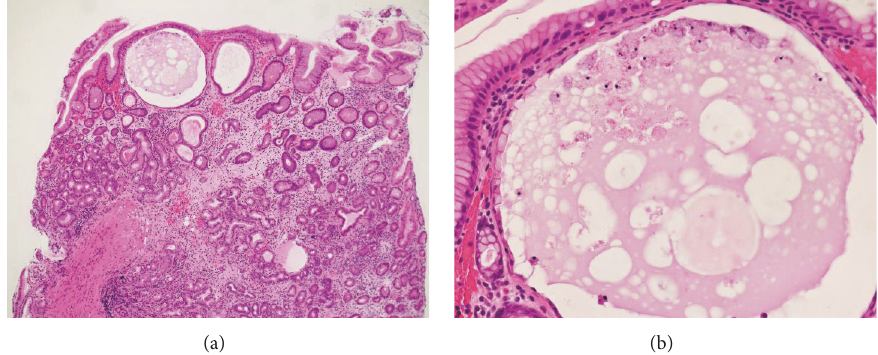
Figure 2: Pathology images of Case 1. Biopsy specimens taken from the gastric mucosa with white globe appearance show cystic dilatation of the gastric glands (hematoxylin and eosin staining, (a): × 4.2, (b): × 20).